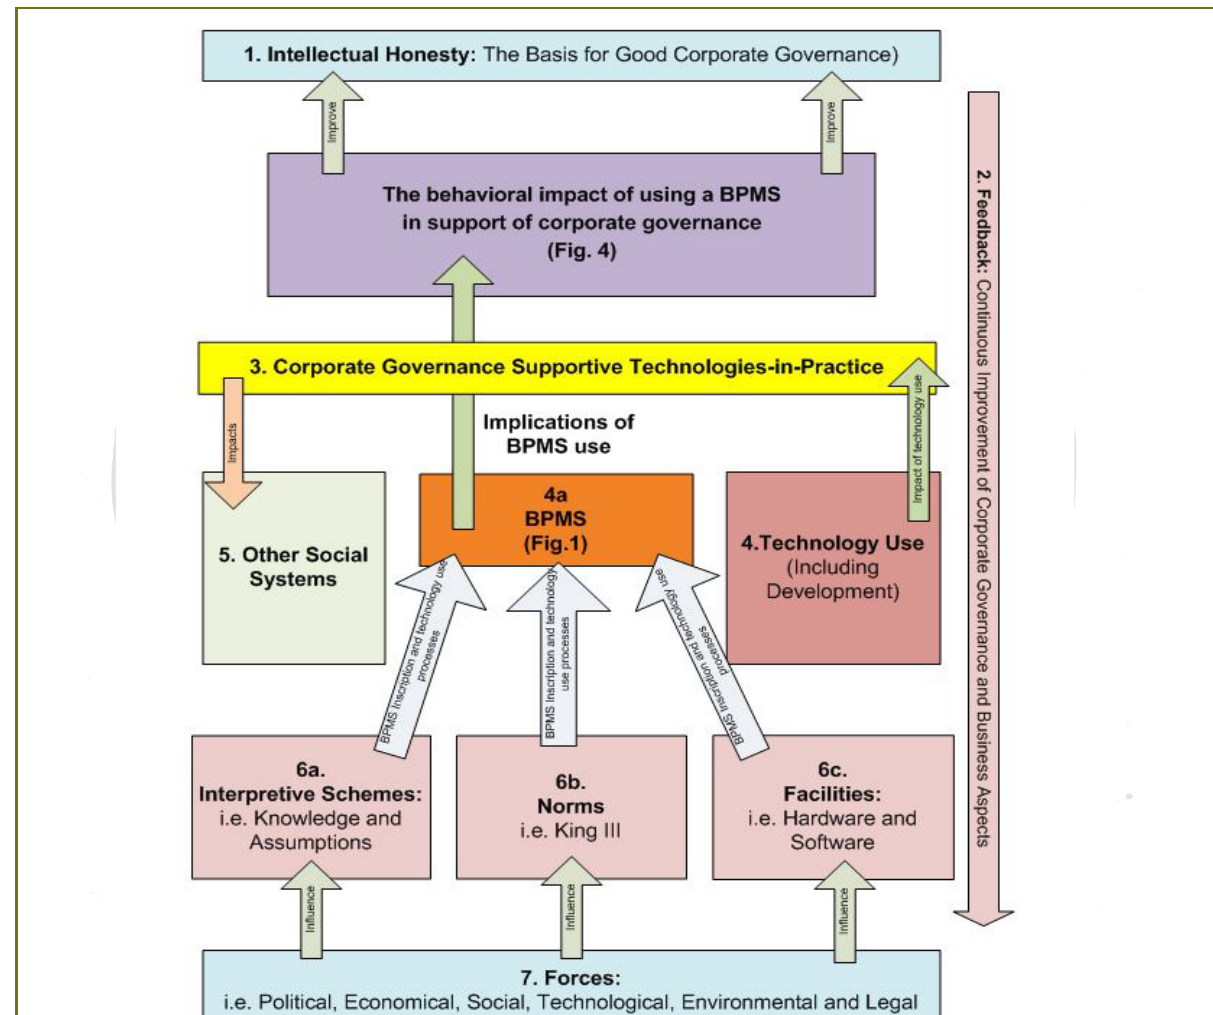
AN ELECTRONIC MONITORING, OBSERVATION AND COMPLIANCE FRAMEWORK FOR CORPORATE GOVERNANCE: A BPM